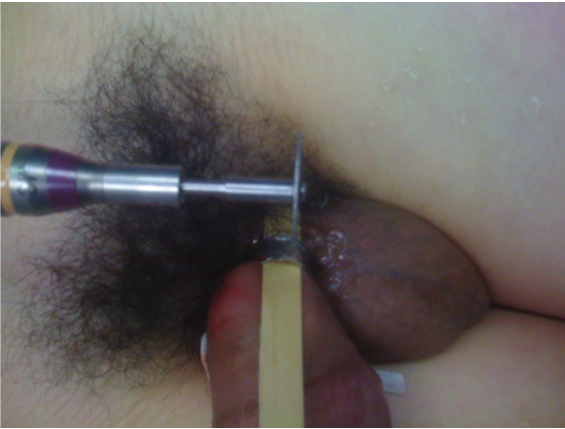
Figure 2: Illustration of tongue depressor placement and oscillating saw used for removal.